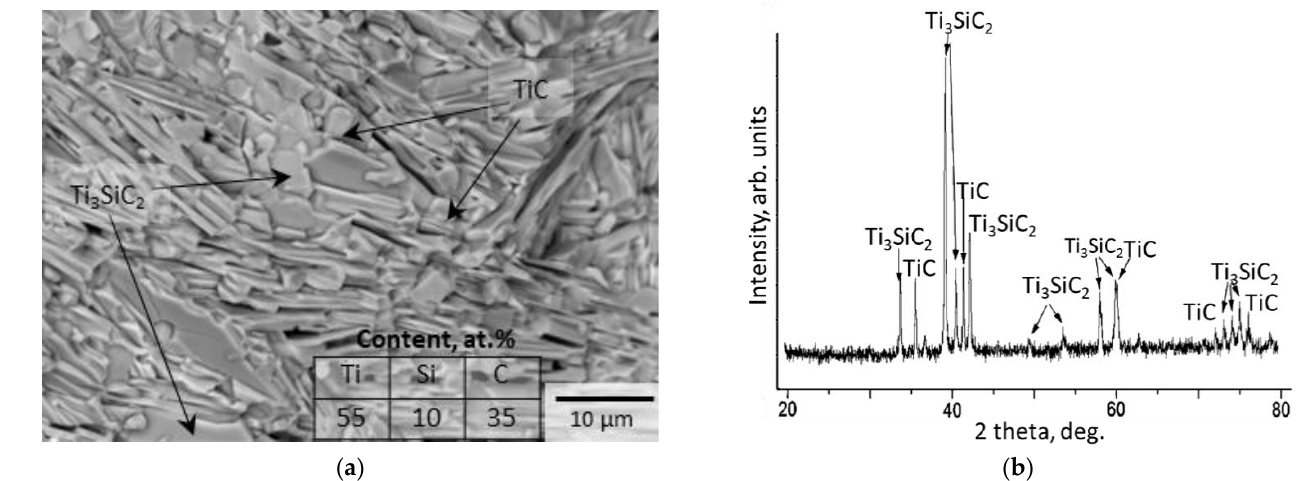
Figure 1. SEM and EDS data ( a ) and diffraction pattern ( b ) of the Ti 3 SiC 2 target.